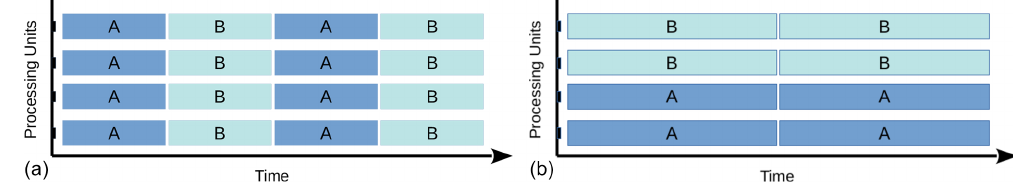
Figure 3. (a) Two model components A and B running on four processing units using only domain decomposition parallelism. (b) The two components run concurrently, each on 2 processing units.